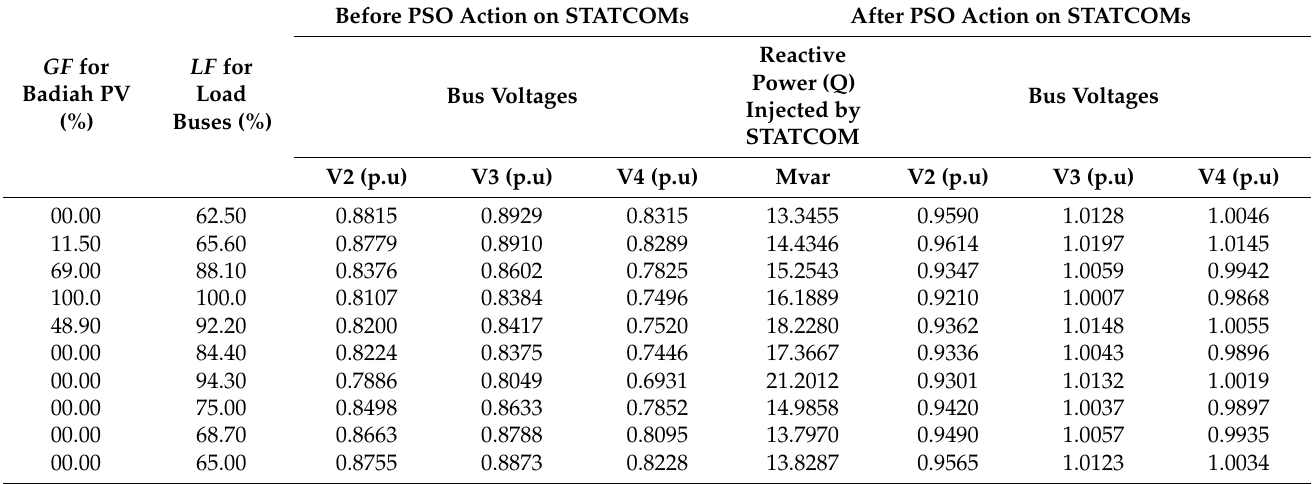
Table 7. PSO results using one STATCOM at TPV2 bus of Badiah PV Farm.